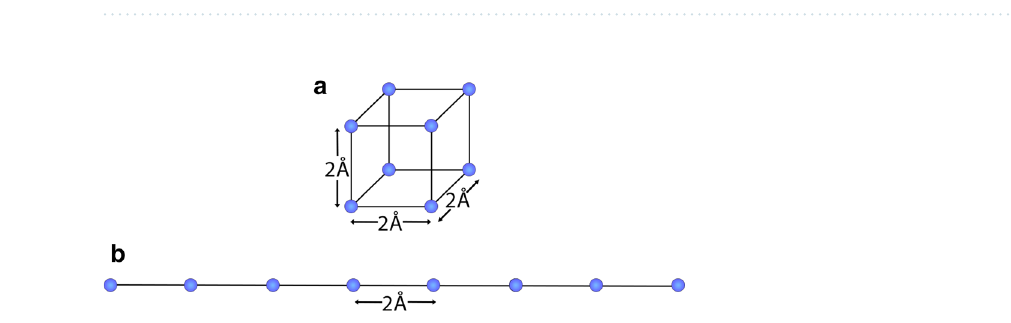
Table 3. Polarizability of bulk materials. wavelength of (cid:31) = 589.3 nm.